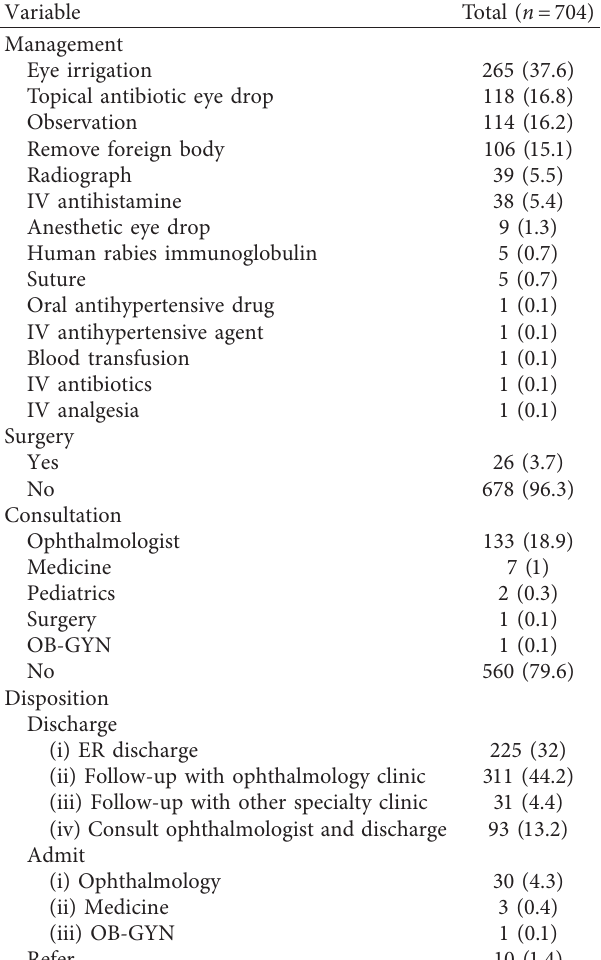
Table 8: Management and outcome of 704 eye-related chief complaint